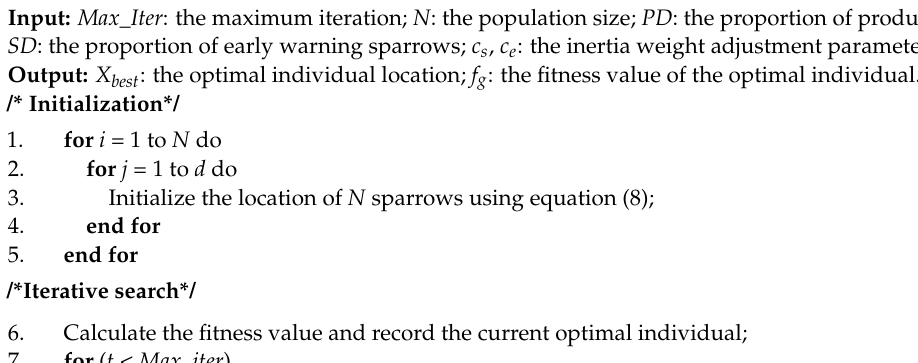
Algorithm 1: The framework of